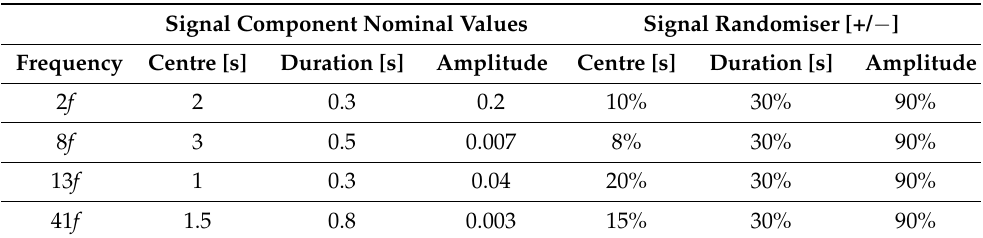
Table 2. Features of signal